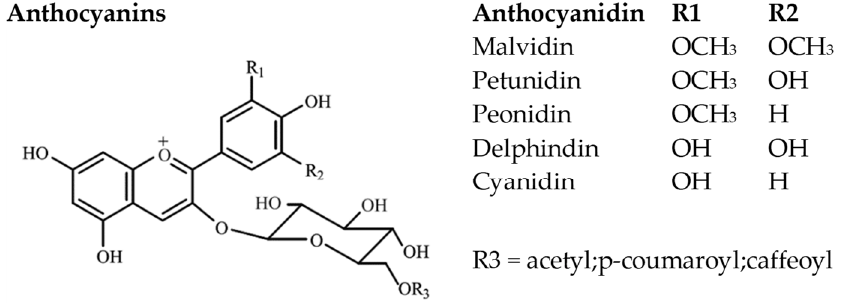
Figure 7. Main anthocyanin chemical structures.